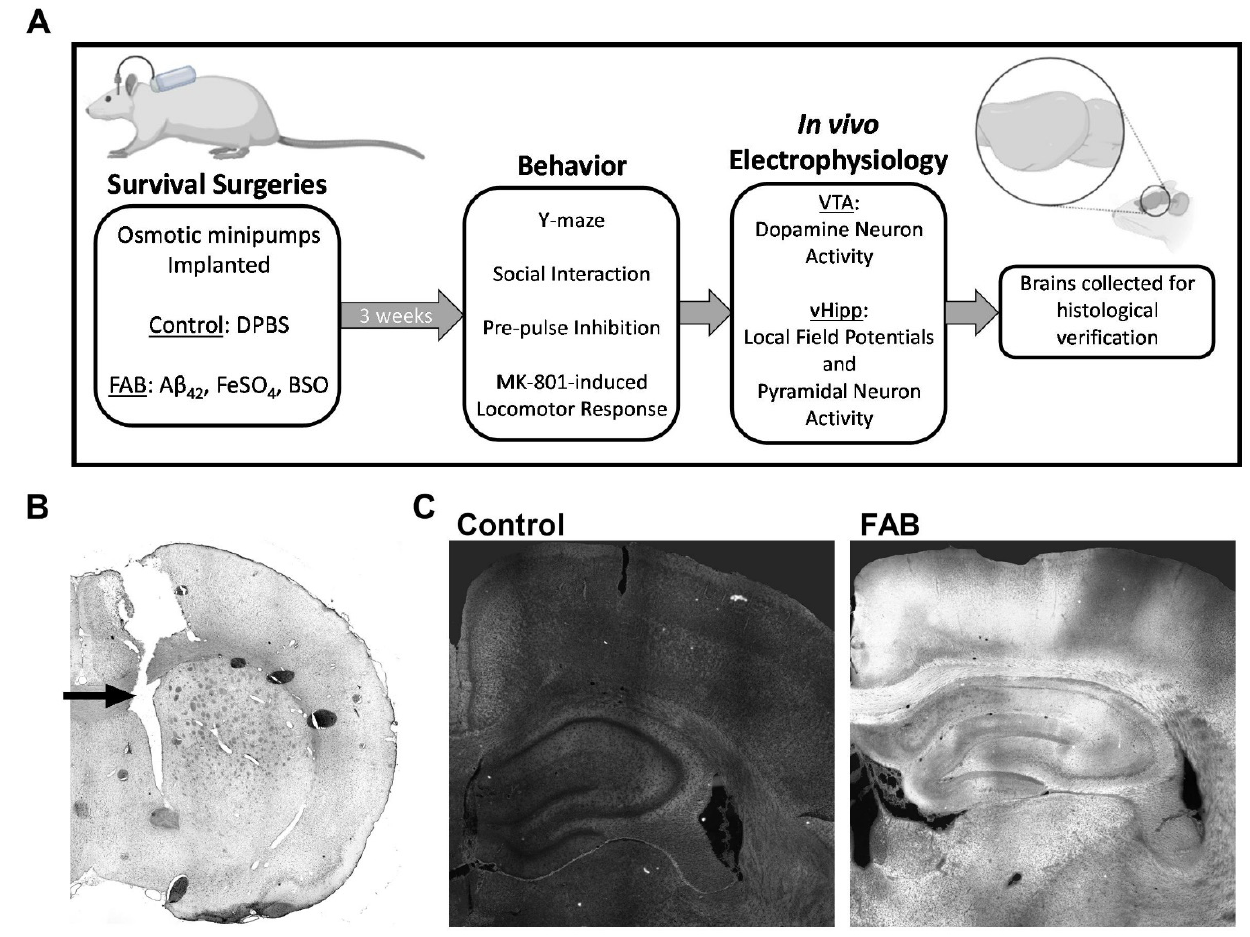
Figure 6. Schematic representation of the experimental timeline ( A ). Representative coronal brain slice displaying a cannula track into the lateral ventricles, indicated by a black arrow ( B ). Representative dark field image of a silver-stained brain from a control (left) and FAB (right) rat, with the brighter areas depicting areas of pathological deposits ( C ). 40× magnification. The icons used were adapted from BioRender.com (2021), retrieved from https://app.biorender.com/illustrations (accessed on 18 August 2021).